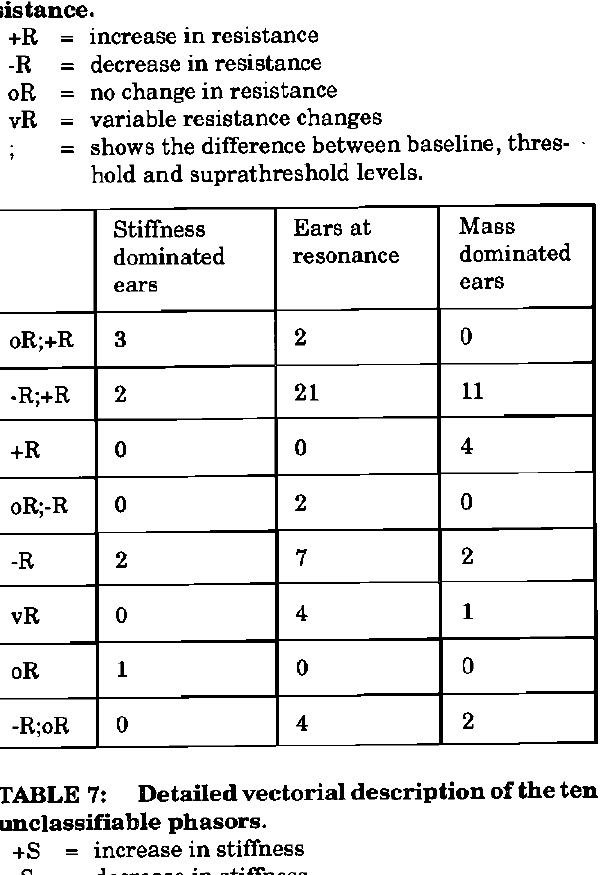
TABLE 5: Vector Analysis: ^Effect of the reflex on stiff- ness reactance.